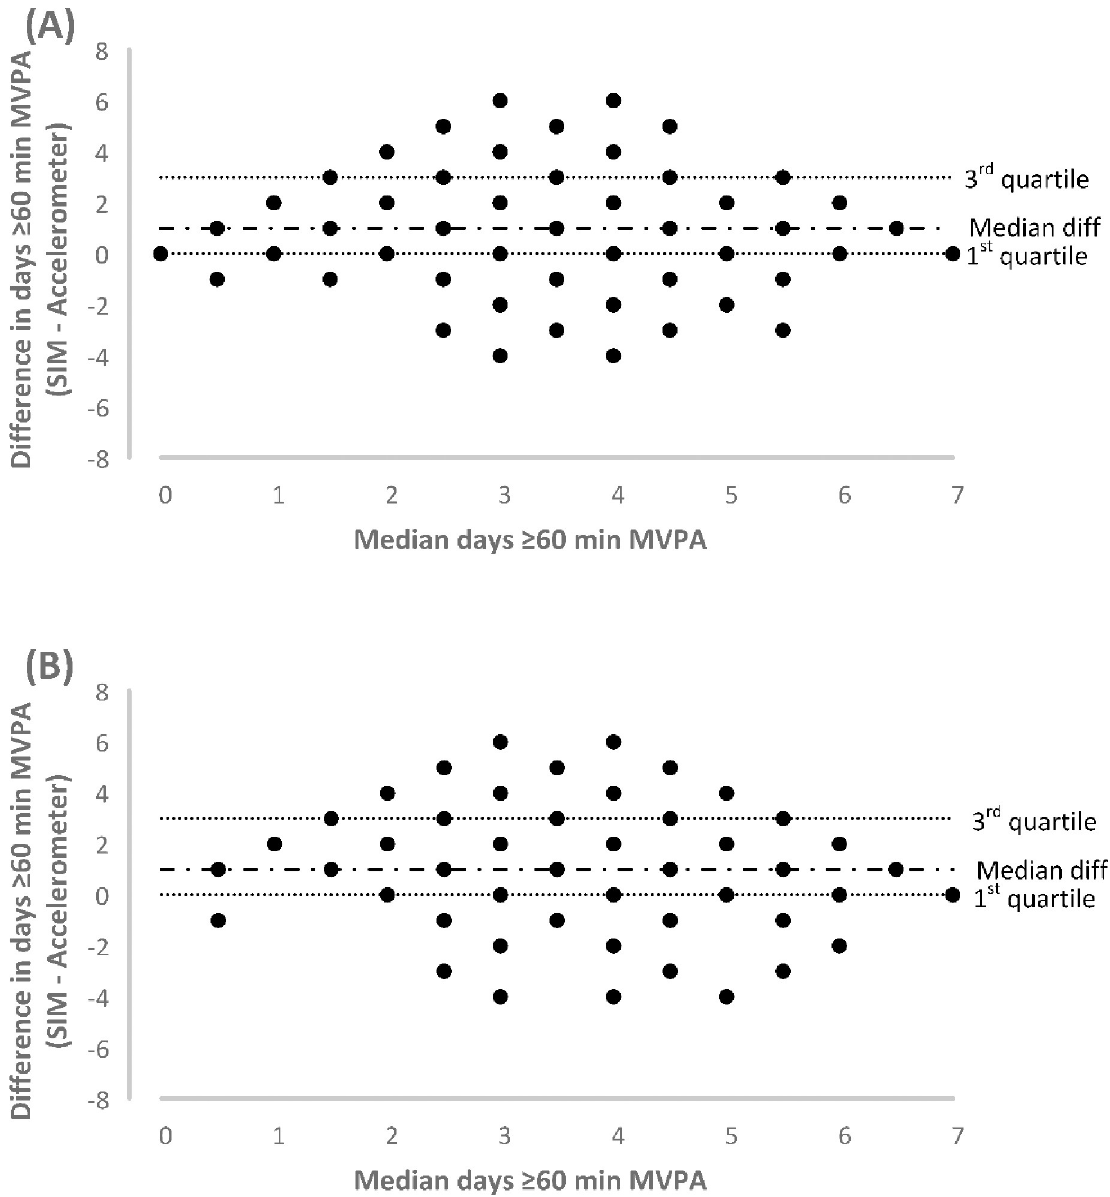
Fig 1. Difference in days � 60 minutes of moderate-to-vigorous intensity physical activity (MVPA) between the single item measure (SIM) and accelerometry: (A) Week one and (B) Week two. Median difference and inter-quartile range for the ordinal distributions are presented as dotted horizontal lines against the median of the two measures (single-item and